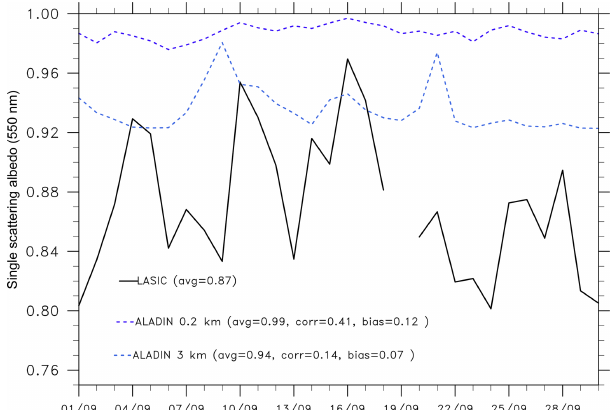
Figure 9. Daily mean in situ SSA estimated at the surface at As- cension Island (LASIC) and simulated with the ALADIN-Climate model at two different altitudes (0.2 and 3km).